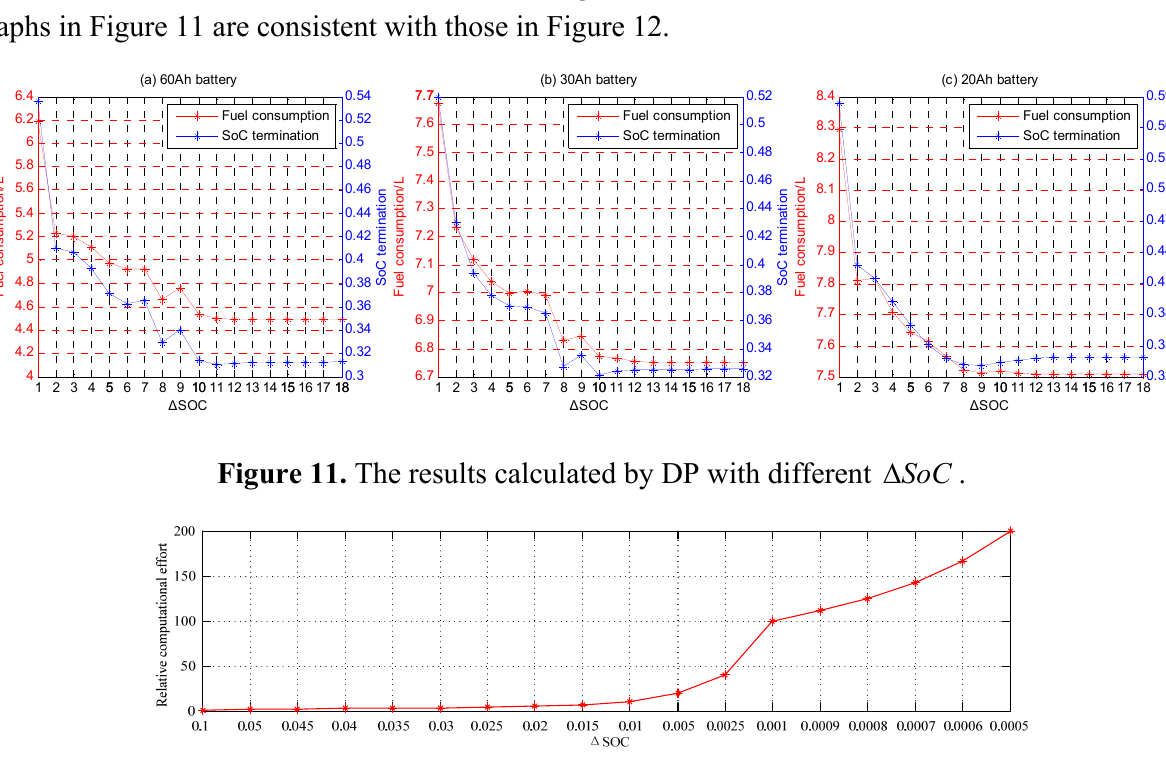
Figure 12. The relative computational load for different SoC 